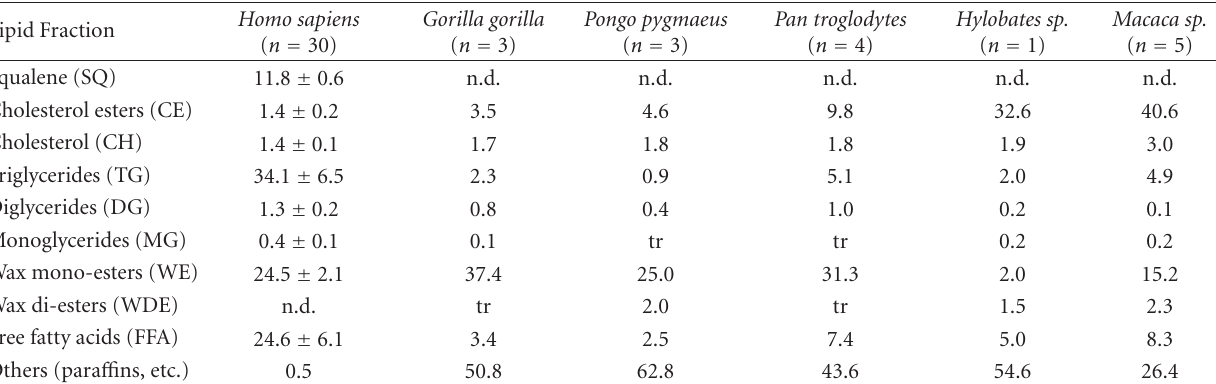
SSLs were sampled from the forehead and upper chest, with diethyl ether cup extraction method [30]. Results for human skin (30 subjects) are expressed as mean ± S.D.; for primates they are the results of the varying number of samples. Macaca sp. sample is a pooled extract of 5 samples, consisting in 1 single individual from each of the following species: Macaca sp., M. mulatta, M. nemestrina, M. assemensis, and M. fascicularis. tr: